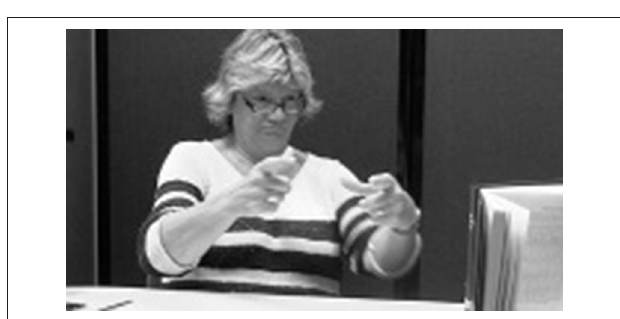
FIGURE 4 | Entity classifier representing